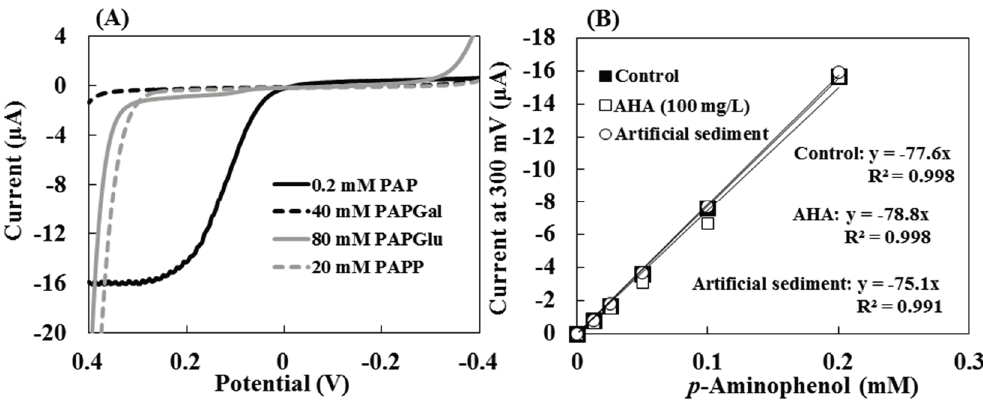
Figure 2. ( A ) The hydrodynamic linear sweep voltammograms of 0.2 mM PAP, 40 mM PAPGal, 80 mM PAPGlu and 20 mM PAPP in MUB, at pH 6.0 with 5% toluene; ( B ) The calibration curve of the mass-transfer limited current of PAP at 0.3 V without (control) or